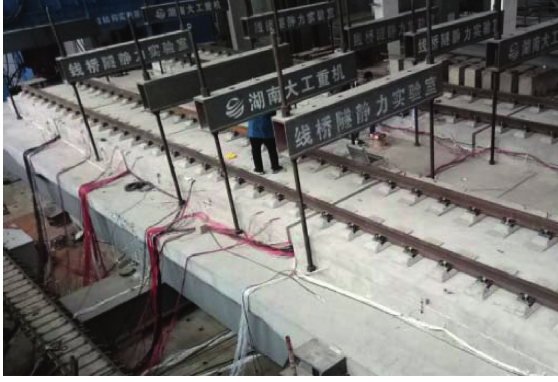
Figure 10: Loading devices on the segment